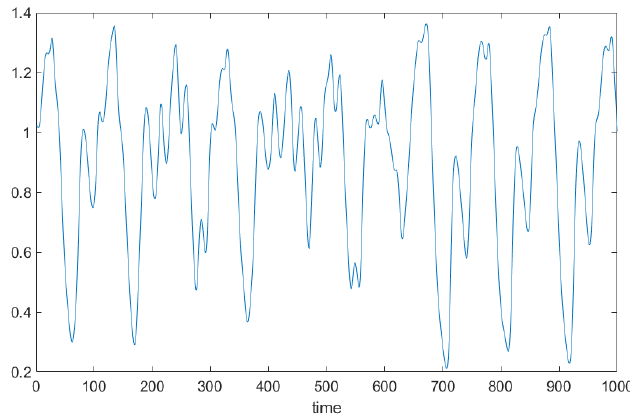
Figure 1. Mackey-Glass time series data (test samples).